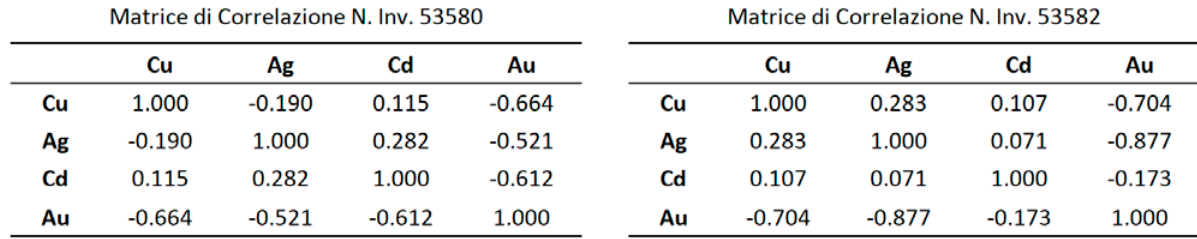
Figure 7. Correlation matrices for each of the pair’s earrings in Fig.